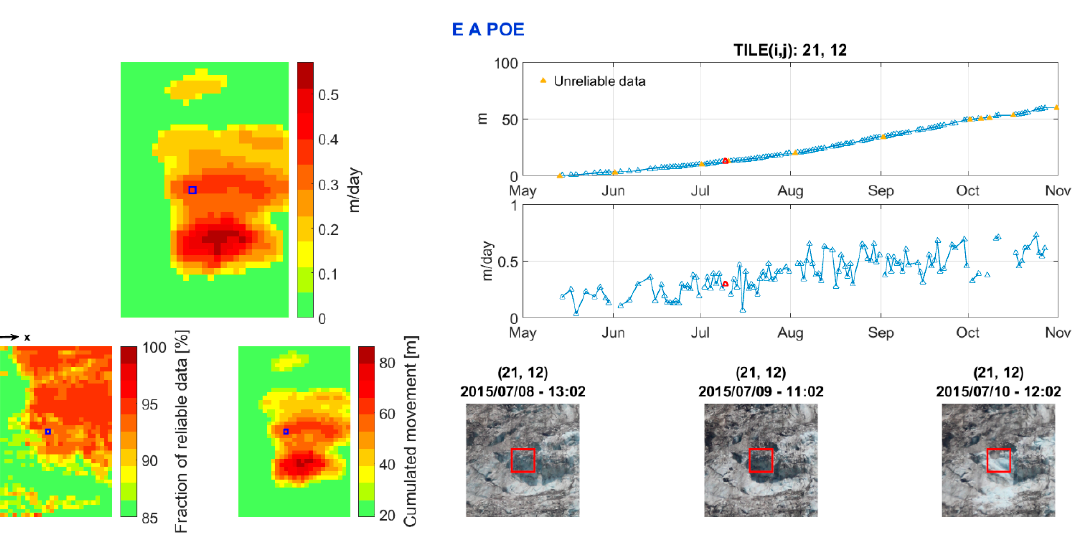
Figure 9. EAPOE output. On the left, there is a mean vertical velocity map ( top ), a fraction of days with acceptable coherence map ( bottom left ) and a cumulative vertical displacement map ( bottom right ). The time series of cumulative displacement and daily velocities of the selected tile are plotted on the right. At the bottom, the images show the glacier evolution.